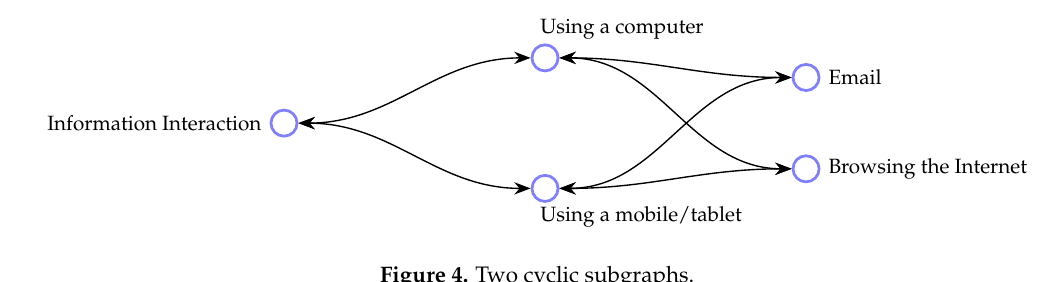
Figure 4. Two cyclic